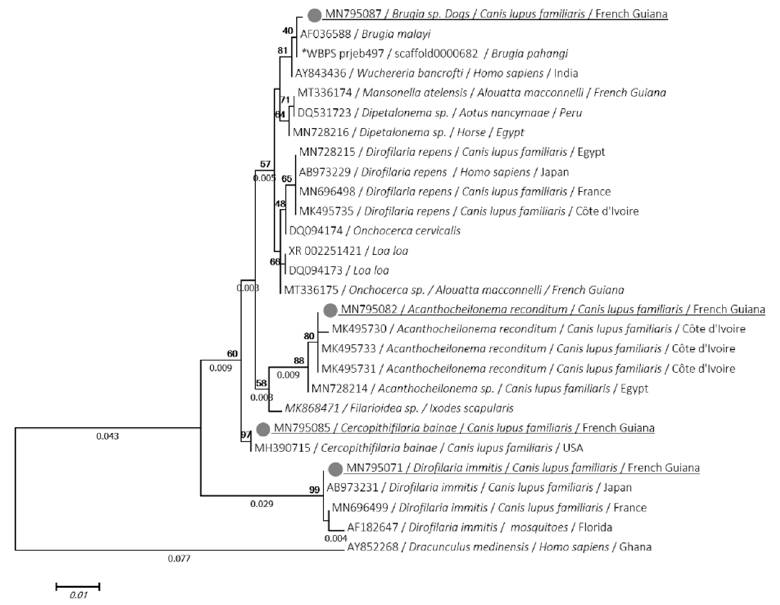
Figure 2. Phylogram of the 18S rRNA gene generated by maximum likelihood method from 28 partial (969) sequences. The tree with the highest log likelihood ( − 2078,7662) is shown. A discrete gamma distribution was used to model evolutionary rate differences among sites (5 categories (+G, parameter = 01254)). Numbers above and below branches are the display of bootstrap replicate values and branches length, respectively. Host, geographical location (when available) and GenBank accession number are indicated in each node. The sequences of the present study are underlined. *: indicates DNA sequences retrieved from Worm database.